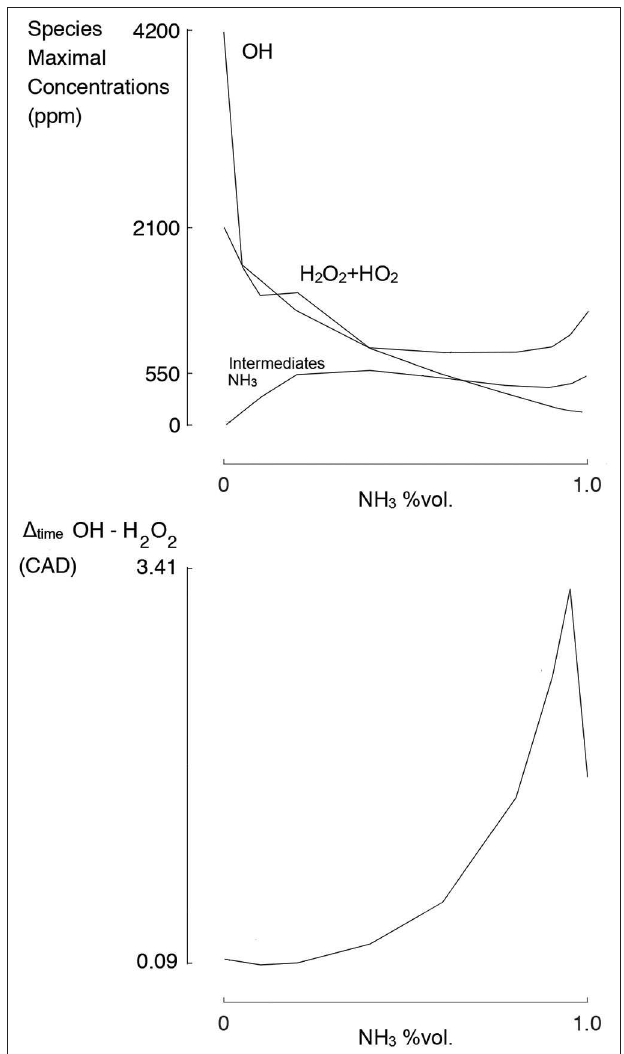
FIGURE 12 | The OH and H 2 O 2 +HO 2 peak concentrations are rapidly decreasing with the ammonia fraction, while the pool of ammonia non-reactive intermediate species is being formed. The initiation period between H 2 O 2 and OH formation is extended.